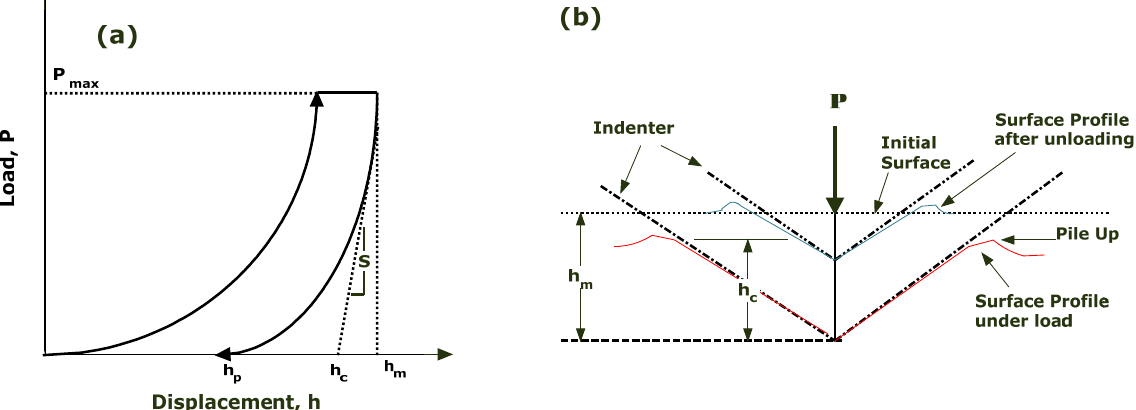
Figure 3. ( a ) Load–depth curve for nanoindentation of viscoelastic material. ( b ) Demonstration of the cross ‐ section of the indenter tip during the loading–unloading portion. the cross-section of the indenter tip during the loading–unloading